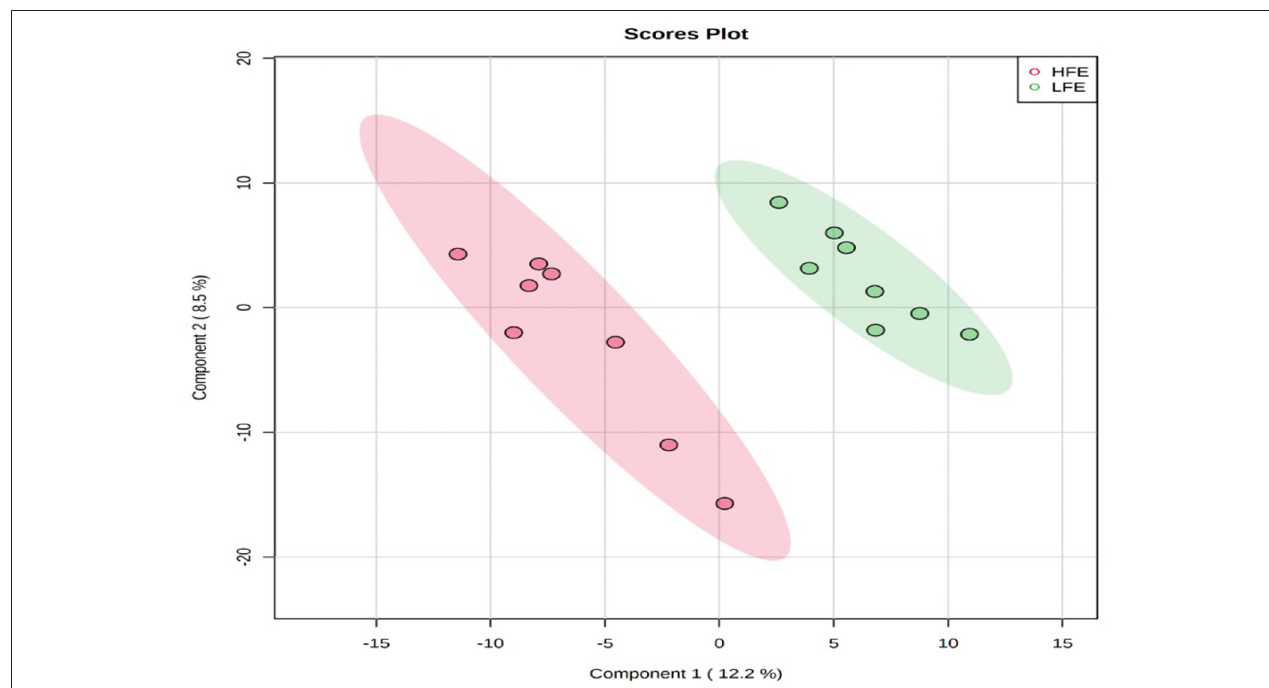
FIGURE 1 | PLS-DA scores plot of amine/phenol-metabolome of LFE and HFE steers. HFE, beef steers with negative residual feed intake; LFE, beef steers with positive residual feed intake.